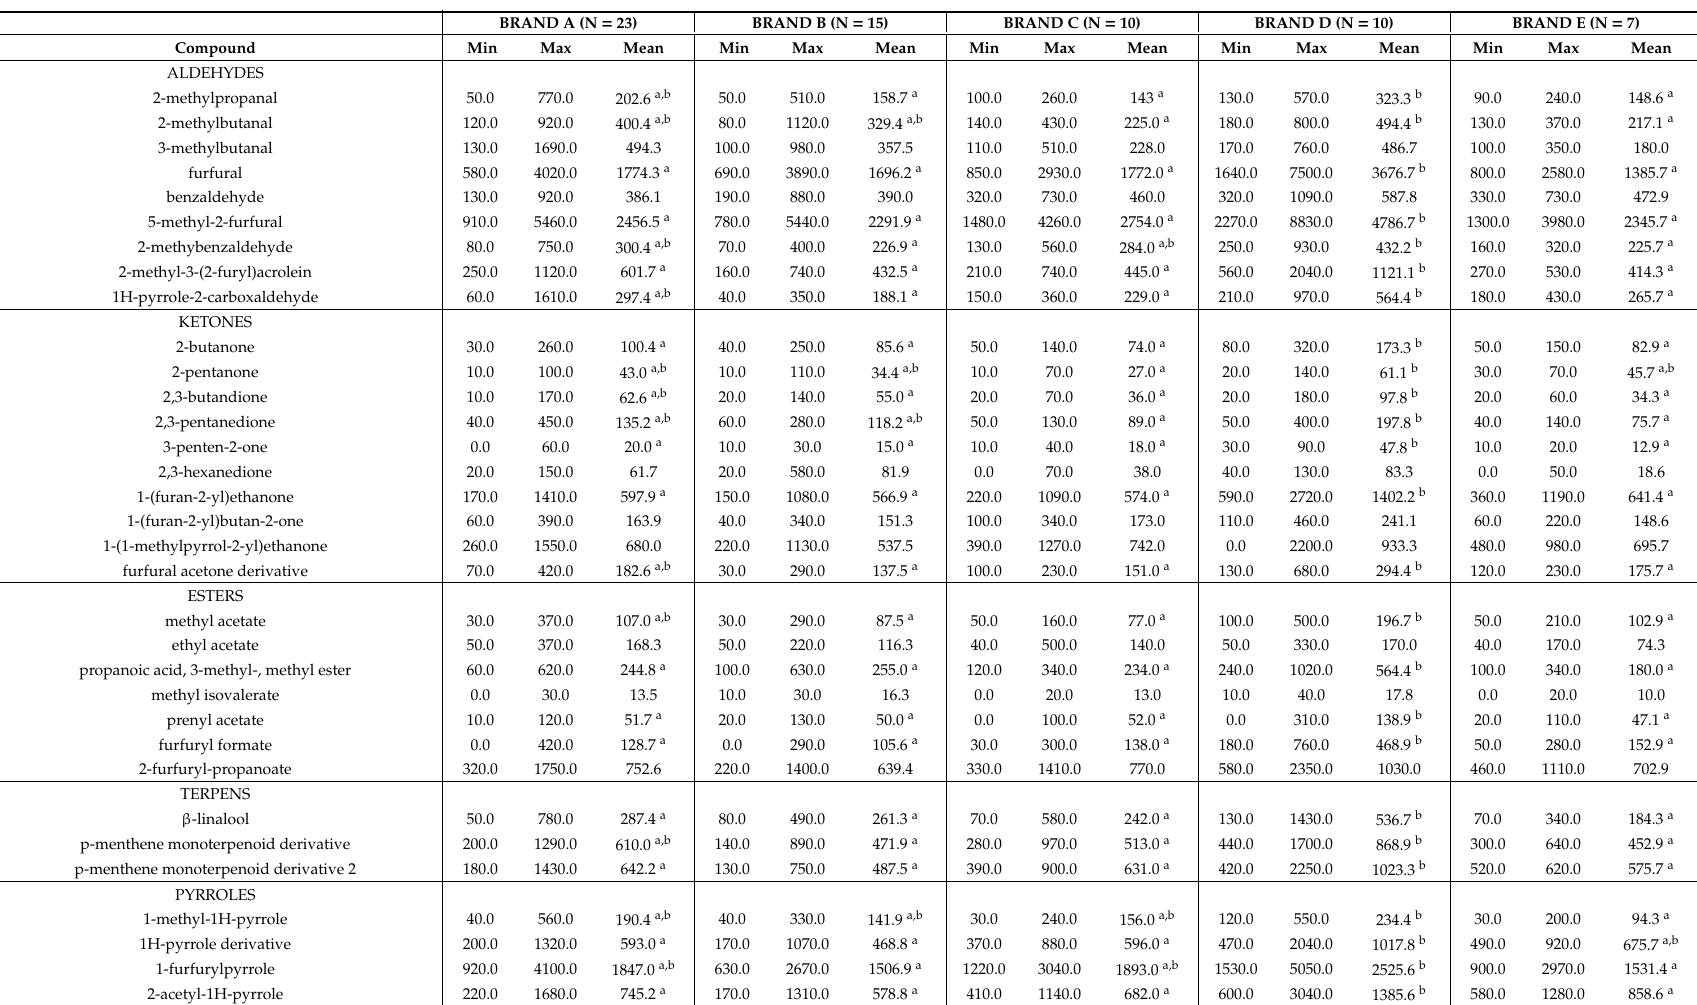
Table 2. Volatile compounds detected in EC samples grouped by chemical class. Minimum (Min), Maximum (Max), and Mean values ( µ g / L) are reported for samples belonging to five commercial Italian brands. Di ff erent letters (when reported) indicate statistically significant di ff erence (ANOVA, p < 0.05); nq = not